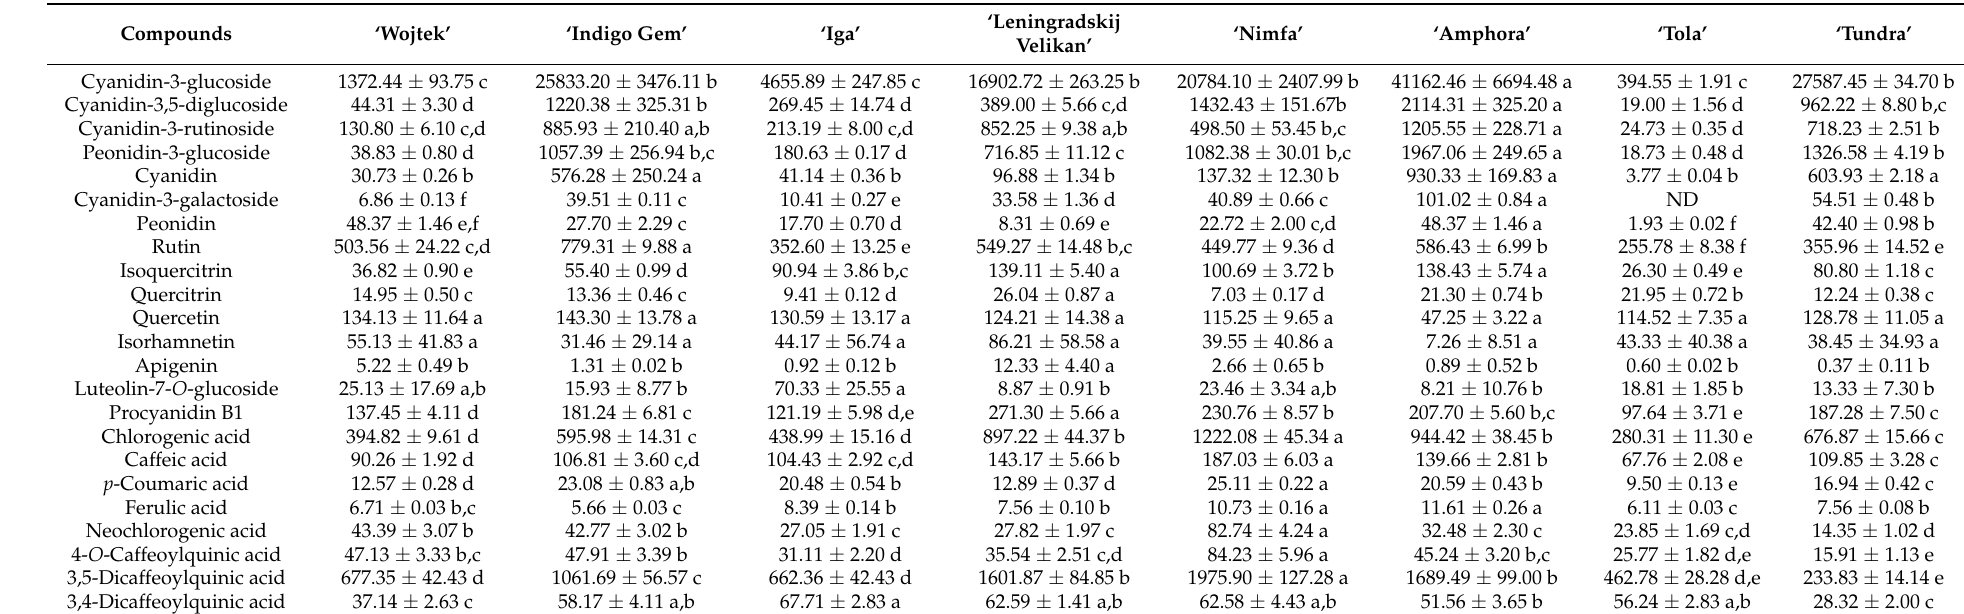
Table 5. Contents of individual phenolic compounds ( µ g/g, DW) in cultivars of L. caerulea fruits .